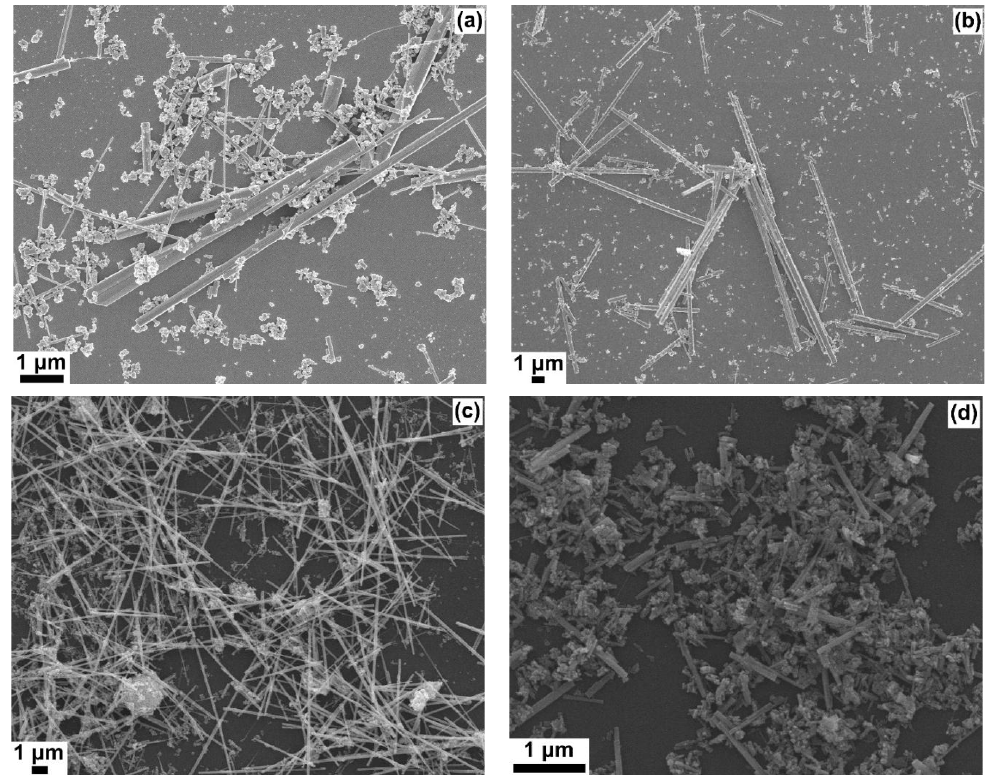
Figure 2. SEM images of Cs 0.3 WO 3 synthesized hydrothermally at 200 °C using 0.18 mmol CsCl, 0.4 mmol WO 3 , 8.8 mmol CH 3 CH 2 CHO, and ( a ) 2.1 mmol NH 3 ‧ H 2 O, 1.4 mmol (NH 4 ) 2 SO 4 ; ( b ) 2.8 mmol 0.4 mmol WO 3 , 8.8 mmol CH 3 CH 2 CHO, and ( a ) 2.1 mmol NH 3 · H 2 O, 1.4 mmol (NH 4 ) 2 SO 4 ; NH 3 ‧ H 2 O, 1.4 mmol (NH 4 ) 2 SO 4 ; ( c ) 2.8 mmol NH 3 ‧ H 2 O, 5 mmol (NH 4 ) 2 SO 4 ; ( d ) 2.8 mmol NH 3 ‧ H 2 O, ( b ) 2.8 mmol NH 3 · H 2 O, 1.4 mmol (NH 4 ) 2 SO 4 ; ( c ) 2.8 mmol NH 3 · H 2 O, 5 mmol (NH 4 ) 2 SO 4 ; 7.5 mmol (NH 4 ) 2 SO 4 . ( d ) 2.8 mmol NH 3 · H 2 O, 7.5 mmol (NH 4 ) 2 SO 4